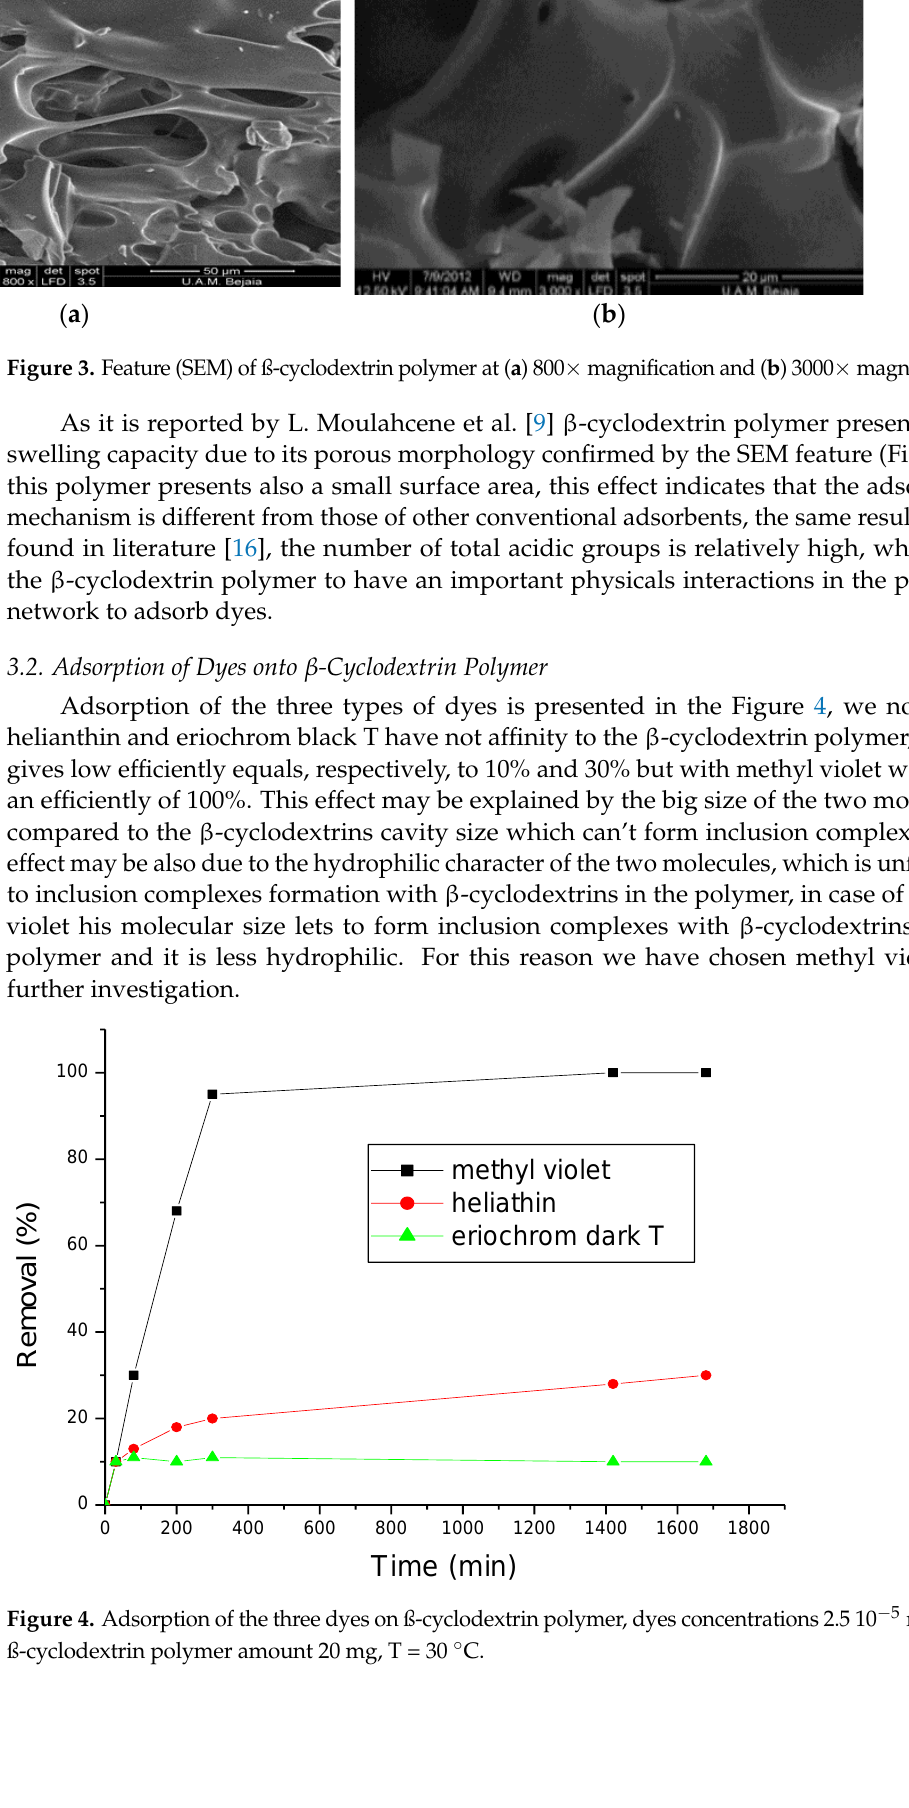
Table 1. Some proprieties of β -cyclodextrin polymer.